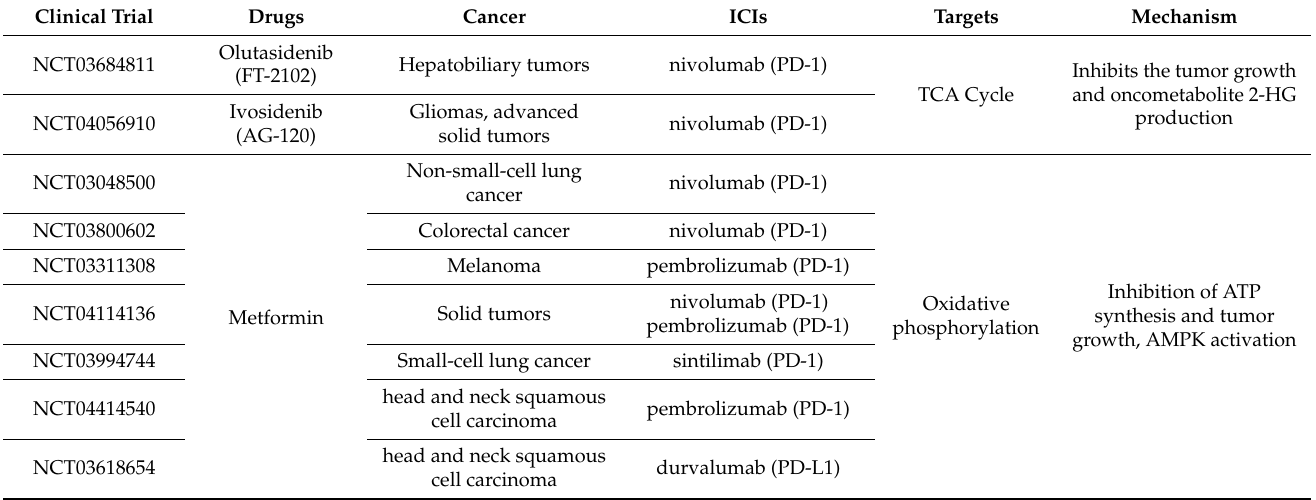
Table 2. Clinical trials using immune checkpoint inhibitors for metabolic